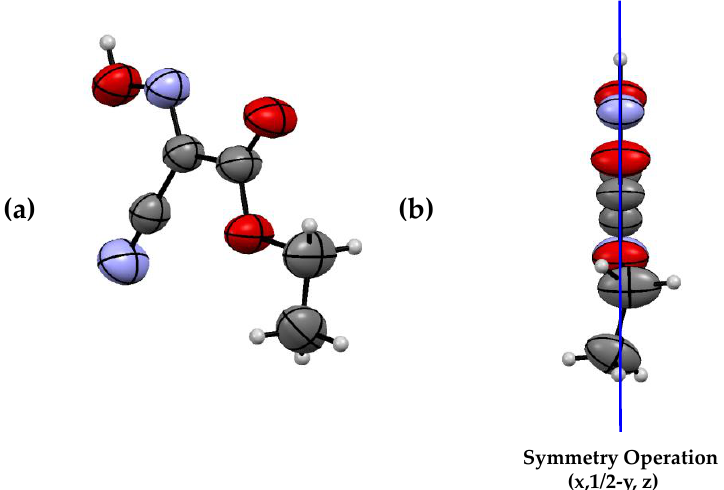
Figure 2. ( a ) ORTEP representation of the orthorhombic polymorph asymmetric unit, ( b ) mirror plane perpendicular to [010].